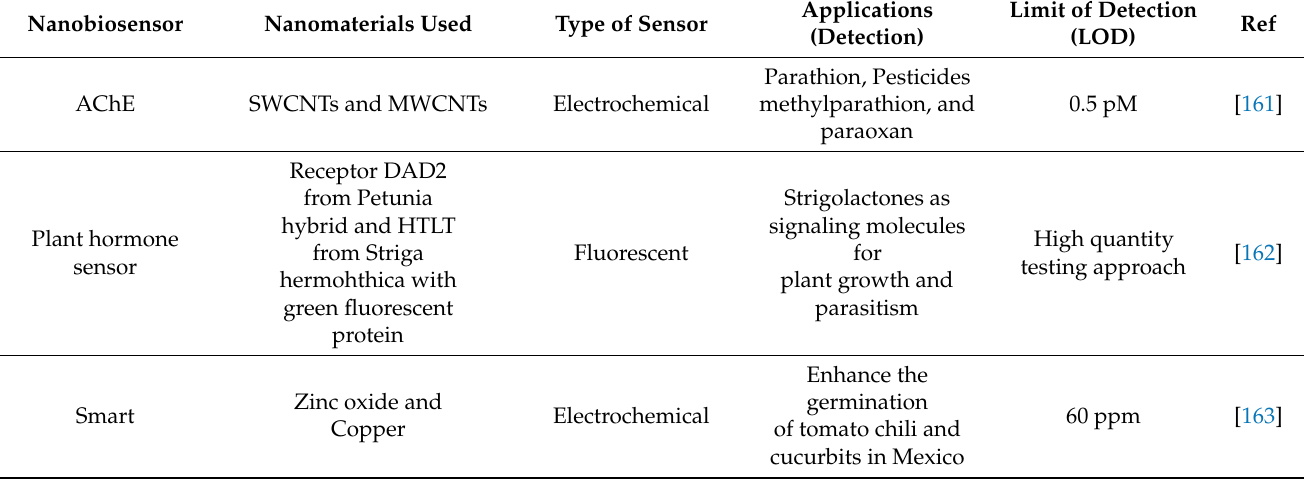
Table 8. Different types of nanobiosensors in environmental applications.